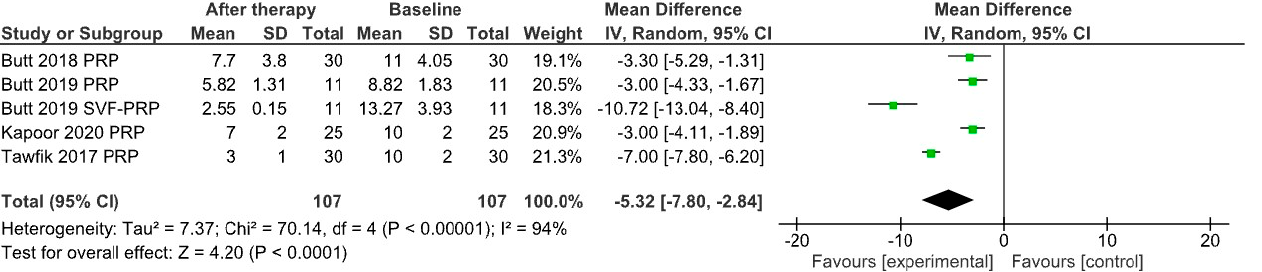
Figure 8. Forrest plot showing effects of PRP treatment on results of pull test in selected study groups.